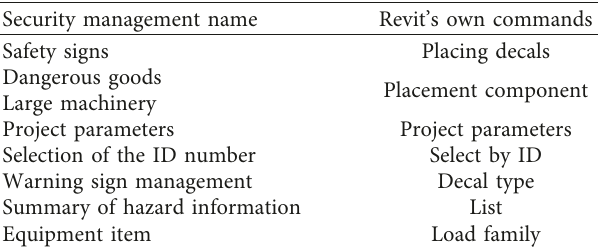
Figure 3: Construction danger source security management module based on Revit platform. Table 4: Application